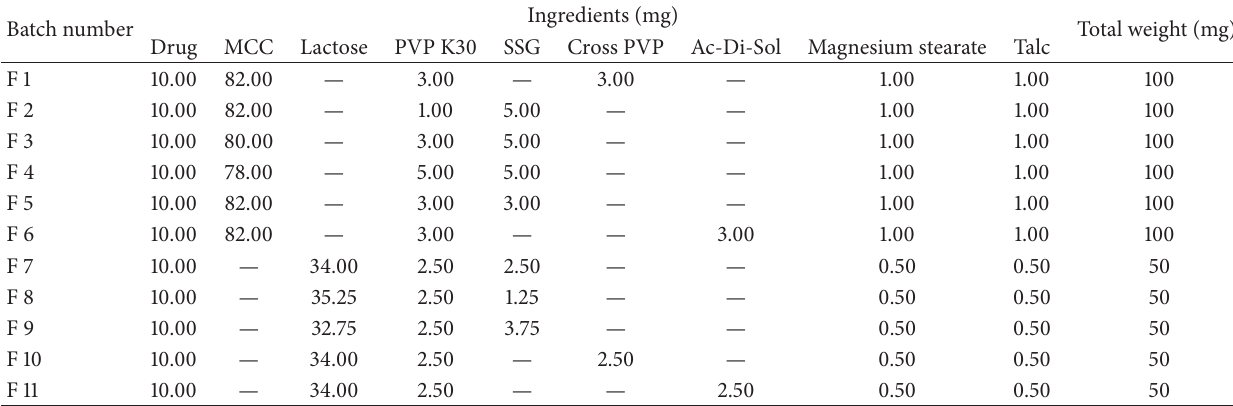
Table 1: Composition of immediate release core tablets of lercanidipine